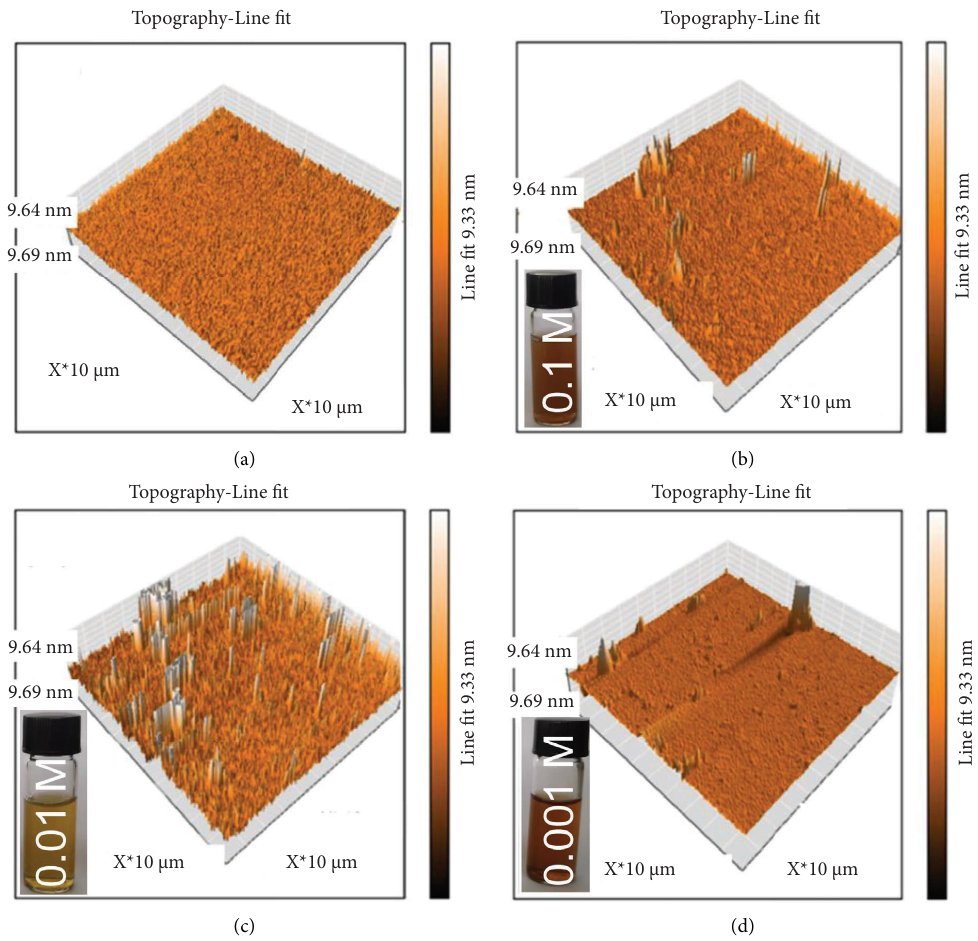
Figure 5: AFM images of various concentrations of AgNO 0.001 M.